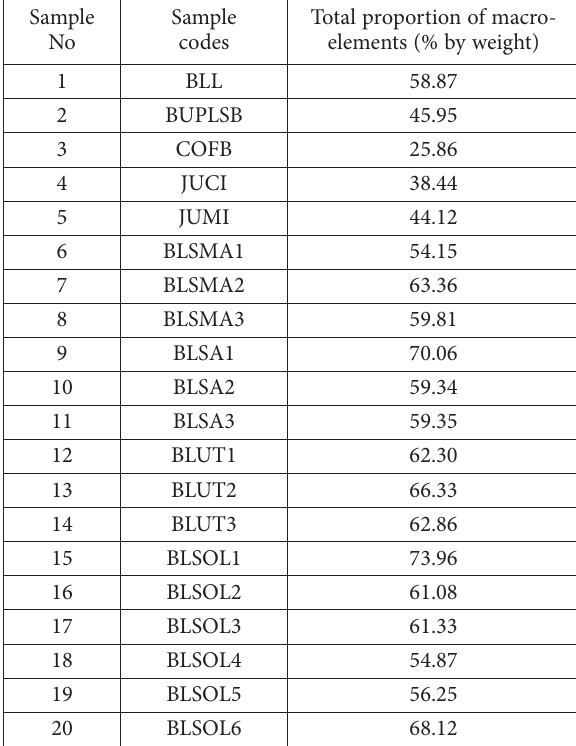
Table 5. Combined concentrations of macro-nutrients (% by weight) in ash samples from ignited plant tissues Sample